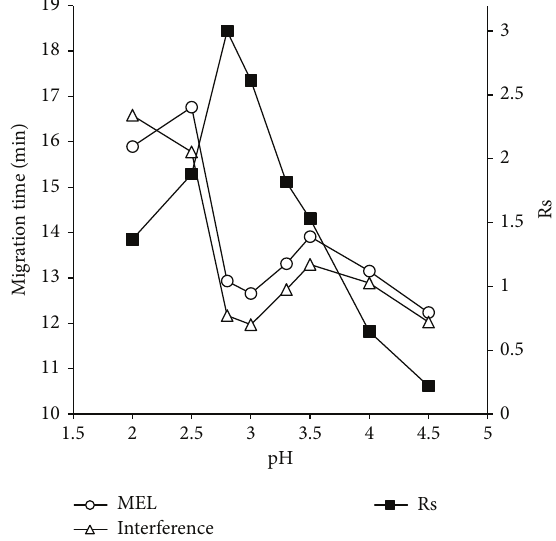
Figure 1: Influence of pH on migration times and Rs